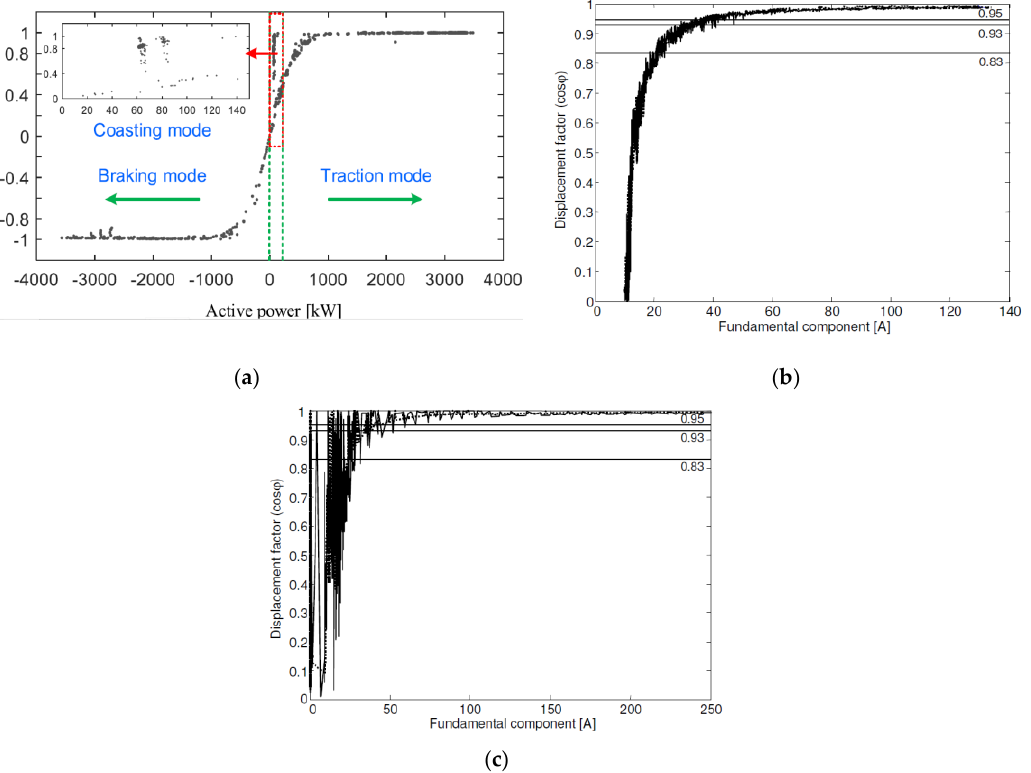
Figure 9. Measured power factor (PF) range for different kinds of modern trains. ( a ) CRH2A-China [94],